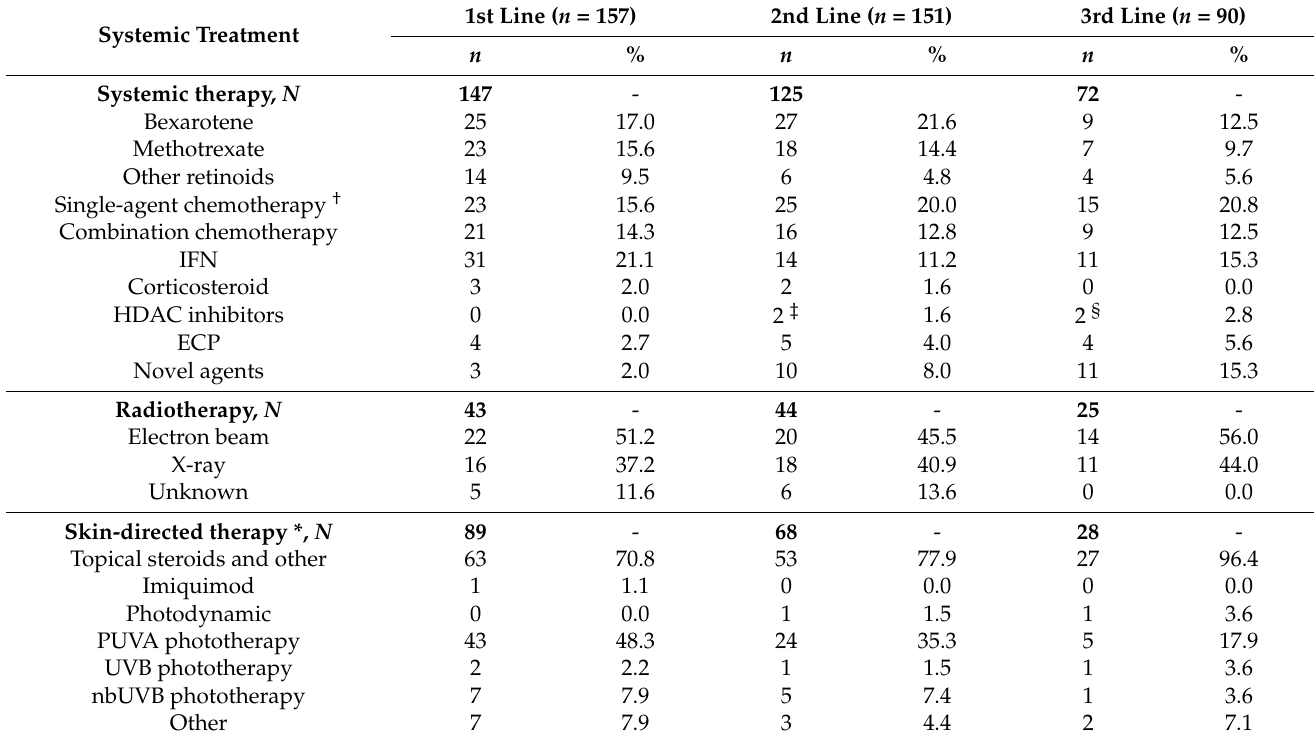
Table 3. Systemic therapies, radiotherapy (RT) and skin-directed therapies across 3 lines of